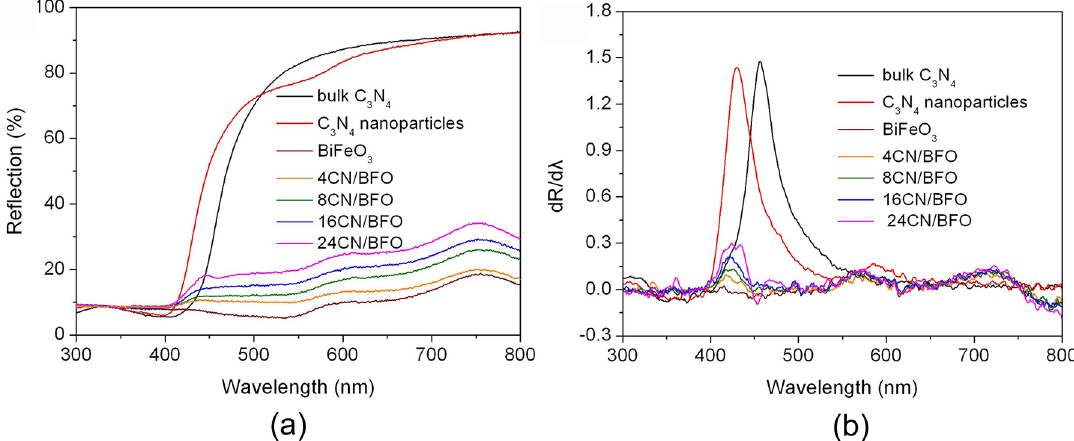
N , g-C N nanoparticles, BiFeO 3 4 3 4